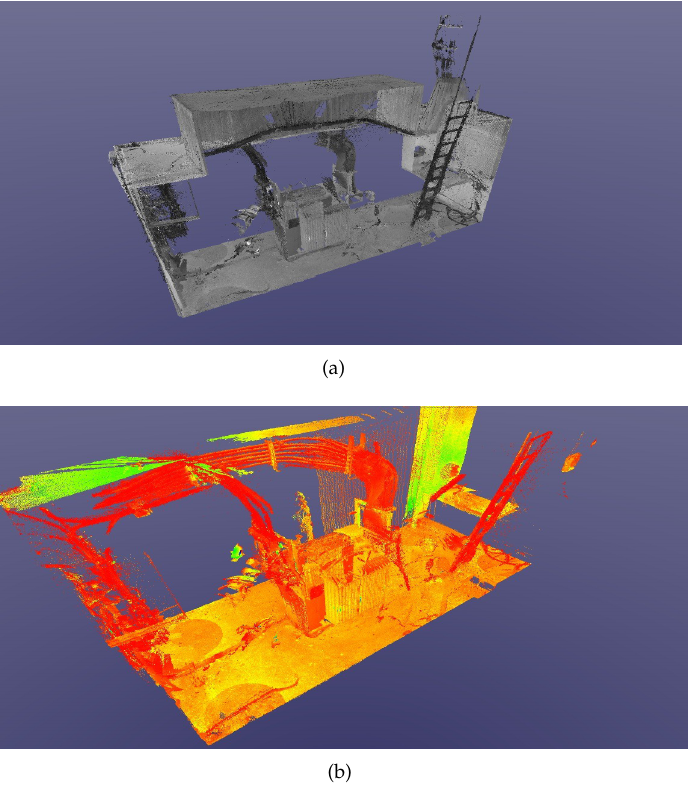
Figure 10. Handheld tool for Cloud Point Data Gathering. ( a ) handheld tool output; ( b ) thermal combination on the handheld